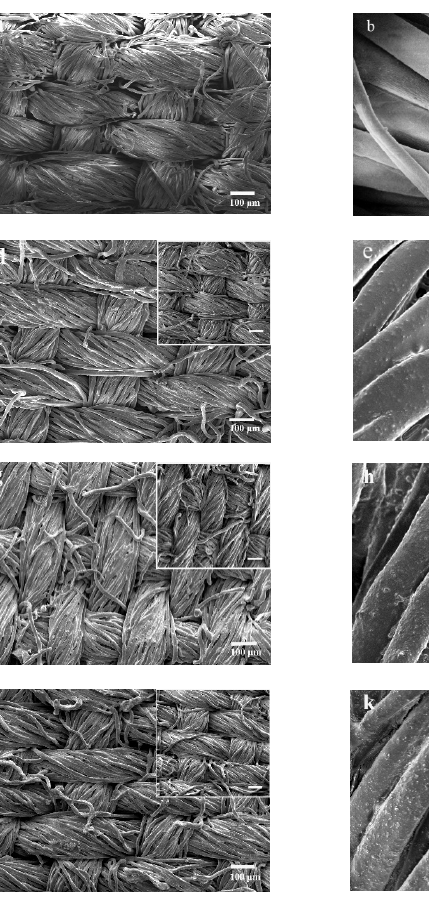
Figure 8. FESEM images of ( a – c ) original fabric at 100, 1000, 3000 magnifications, respectively, ( d – f ) FT10 at 100, 1000, 3000 magnifications, respectively, ( g – i ) FT20 at 100, 1000, 3000 magnifications, respectively, ( j – l ) FT30 at 100, 1000, 3000 magnifications, respectively, and the insets show the corresponding FESEM images of functional textile after 10 wash cycles at 100, 1000, 3000, respectively.